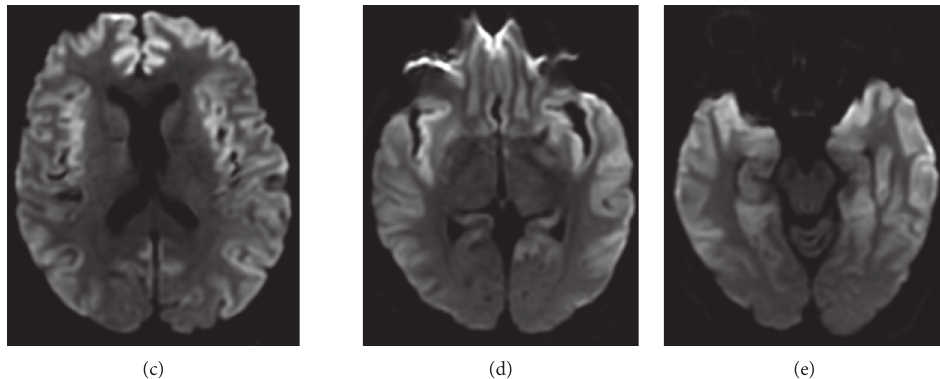
Figure 4: Slices of axial brain MRI performed 15 hours after CT head. (a) T1 sequence showing bilateral hyperintense basal ganglia characteristic of chronic hepatic encephalopathy. (b) T2 FLARE sequence showing bilaterally symmetric intensities of the frontal and insular cortex. (c–e) DWI sequence showing prominent gray matter diffusion restriction of the bilateral frontal, temporal, parietal, and insular